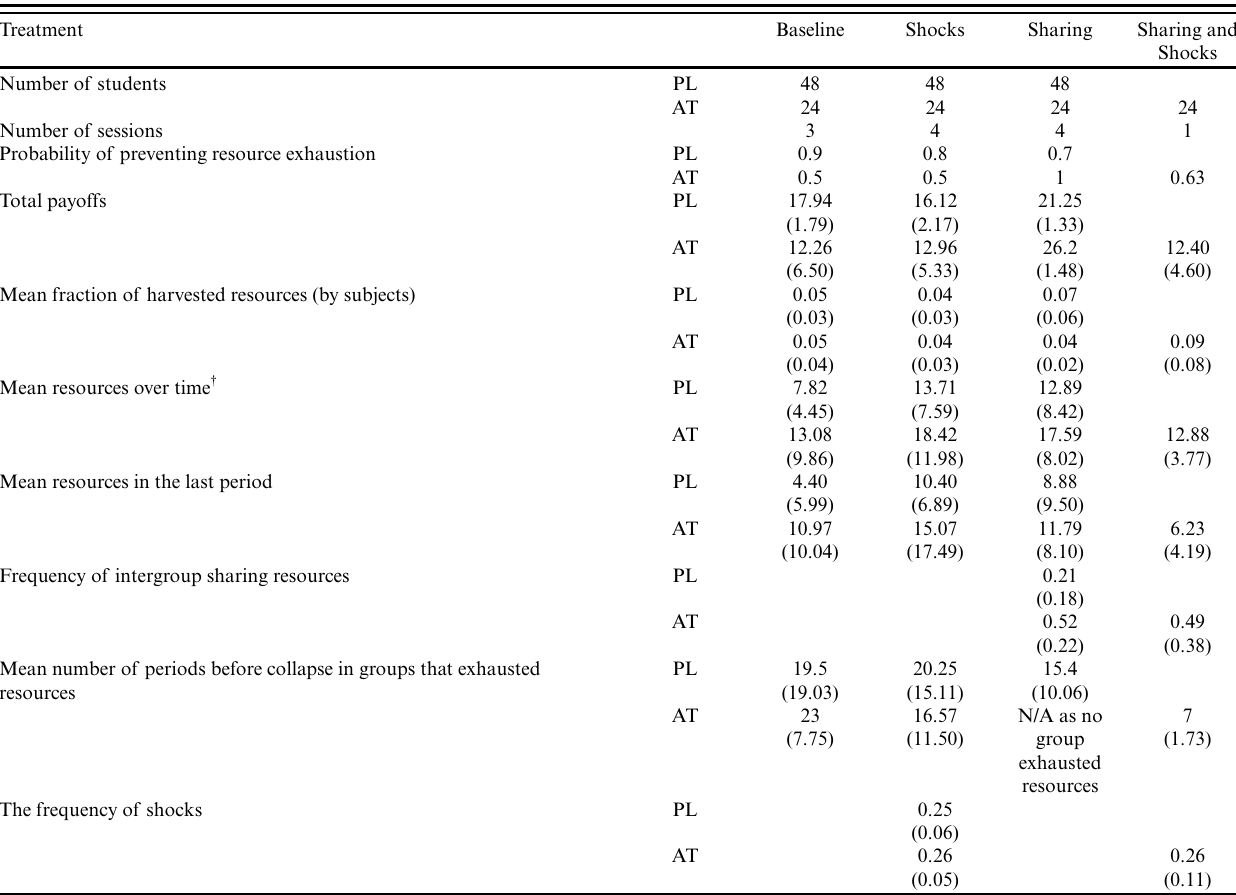
Table 1 . Mean statistics. Standard deviation in brackets. PL = Poland, AT =